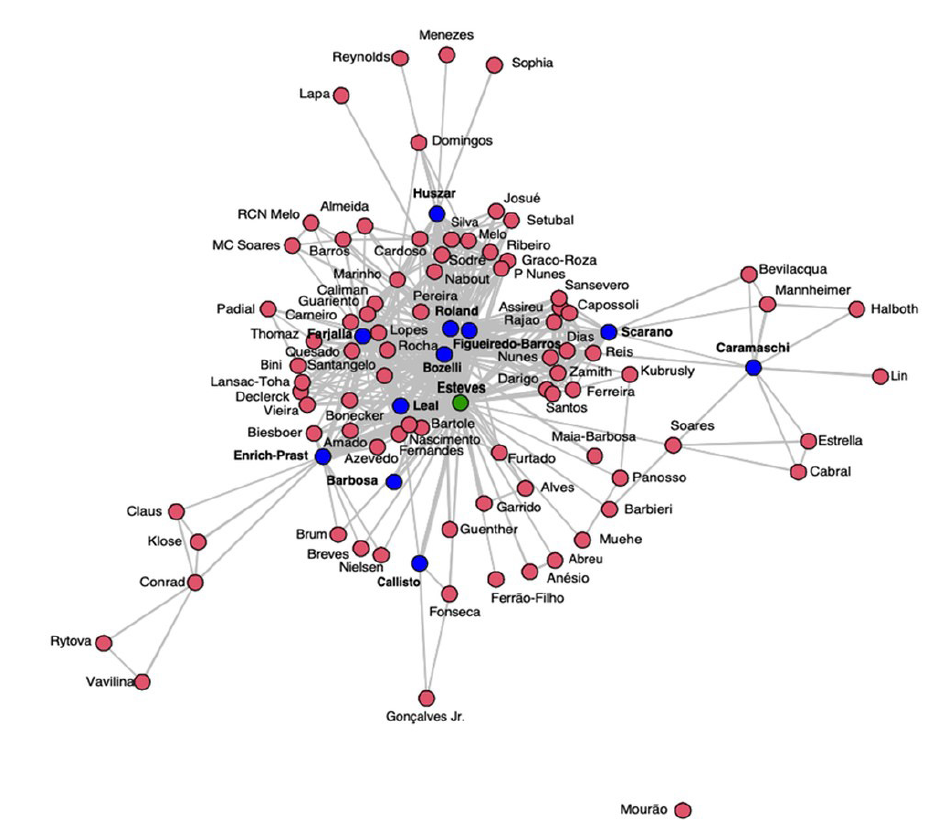
Figure 6. Co-authors network based on the list of co-authors of the publications included in the systematic review. Fonseca and Leal refer to the same author, but were consider separately as cited in the original studies in order to avoid further confusions. In the network, each node represents a co-author. The green node represents the centrality of the network, where the author is present in the majority of publications (n > 50), and the blue nodes are the most frequent co-authors (n > 5). N = 94, N = 460, connectance = vertices total edges Acta Limnologica Brasiliensia, 2023, vol. 35, e2